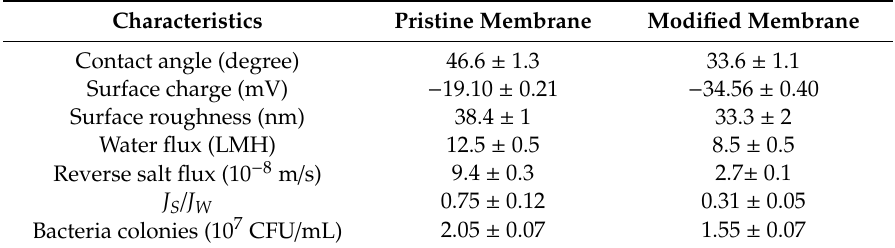
Table 1. Characteristics of the pristine and modified TFC–FO membranes a